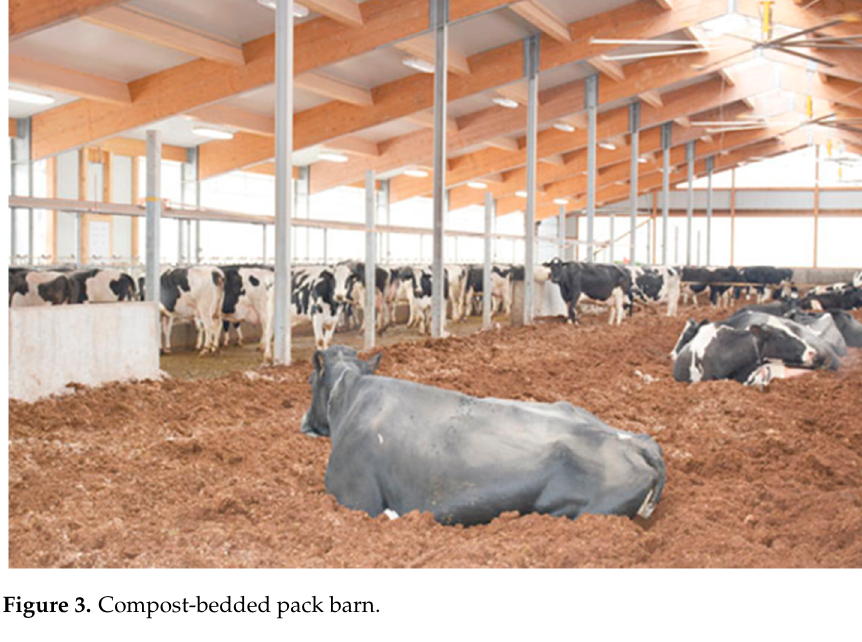
Figure 3. Compost-bedded pack barn.